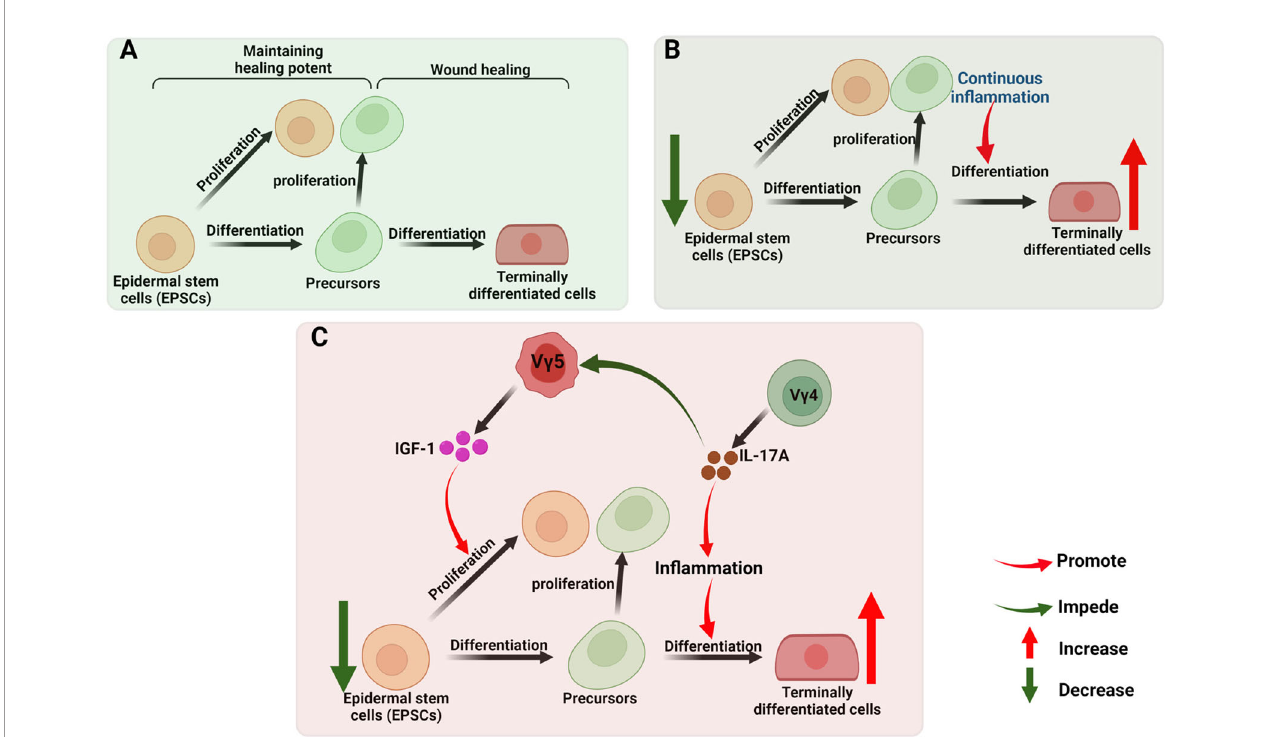
FIGURE 4 | gd T cells in chronic wound healing. (A) The robust activation of EPSCs and ef fi cient recruitment of their progeny towards an epidermal lineage are crucial in the re-establishment of an intact keratinocyte layer during wound healing. The balance of proliferation of pluripotent EPSCs (maintaining healing potent) and their differentiation into terminally differentiated cells (wound healing) are pivotal; (B) In chronic or refractory wound, persistent in fl ammatory condition leads to excessive proliferation and differentiation, with the sacri fi ce of subsequent loss of the stem cell reservoir. (C) In chronic or refractory wound, continuous secretion of IL-17A by V g 4 leads sustained in fl ammation which promotes the excessive differentiation, while suppresses the level of IGF-1 produced by DETCs bene fi cial for the proliferation of EPSCs, this inference is worthy to be